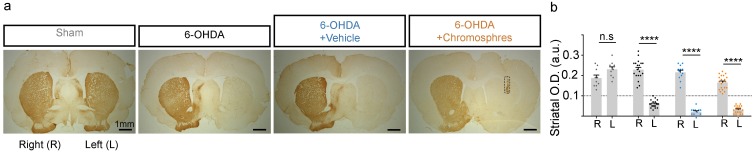
Density of dopaminergic fibers in the striatum of all animals used for long-term behavioral evaluations.The degree of dopaminergic denervation in the striatum was measured to corroborate the effective destruction of the dopaminergic terminals. (a) Representative photographs of TH immunohistochemistry in striatal coronal sections obtained with a stereo-microscope for the experimental and control groups denoted in the figure. (b) Optical density of TH+ signal for the two hemispheres was determined separately from three striatal sections per animal for all the animals used in the long-term behavioral experiments described thus far (i.e. those evaluated up to 12 wpg). The data in the graph correspond to the following experimental groups: Sham (n = 10 randomly selected animals, gray dots), 6-OHDA (n = 19, black dots), 6-OHDA + vehicle (n = 12, blue dots), 6-OHDA + chromospheres (n = 21, orange dots). For animals with chromosphere grafts, we excluded from the densitometry analysis the TH+ area that corresponds to the graft (a, indicated by a dotted box). R, right hemisphere; L, left hemisphere. Significant differences were observed only between the lesioned (left) and non-lesioned (right) hemispheres in animals treated with 6-OHDA (multivariate ANOVA, P < 0.05, F = 27.89, DF = 6, p < 0.0001; followed by Tukey´s multiple comparisons post hoc test, P < 0.0001****). Error bars are the SEM. Scale bar is 1 mm.